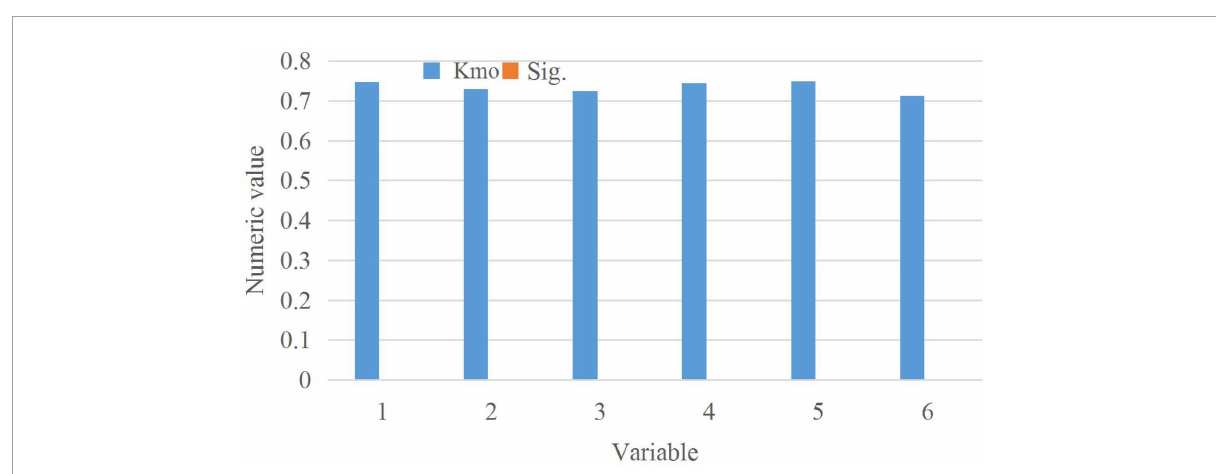
FIGURE7 Cronbach coefficient and Sig value for reliability test.